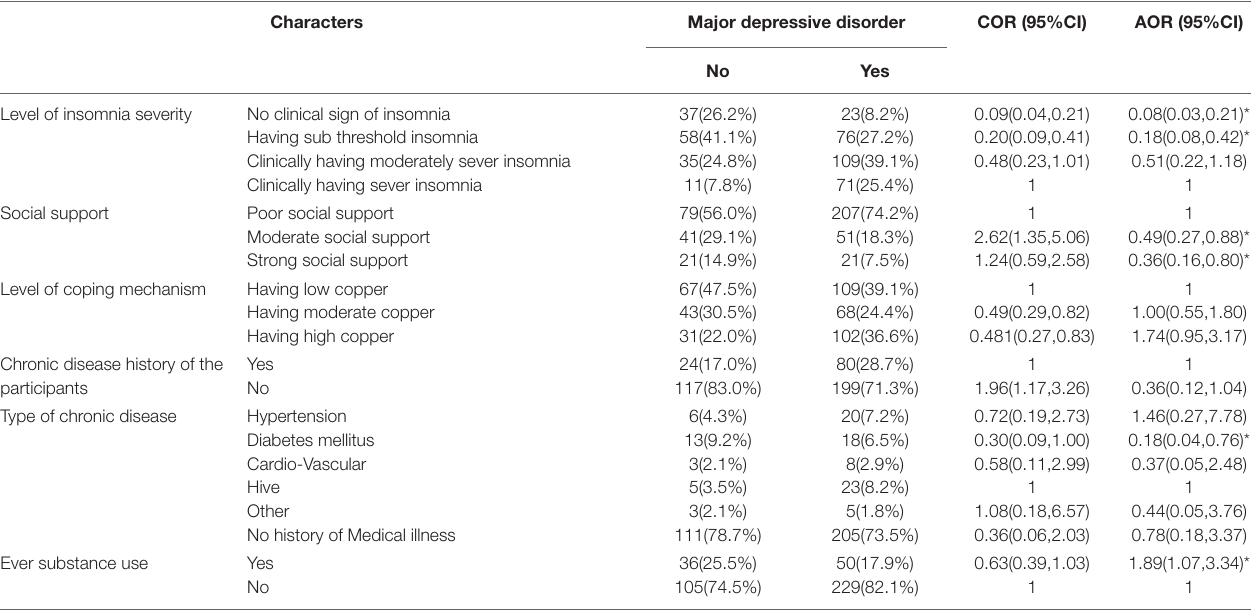
TABLE 5 | Multiple logistic regression: Factors associated with major depressive disorder level of severity of insomnia, social support, copping mechanism, chronic disease, and substance use with major-depressive disorder during COVID-19 pandemic among Dessie town prisoners, in Dessie Amhara region, Northeast Ethiopia, October 2020; ( n =